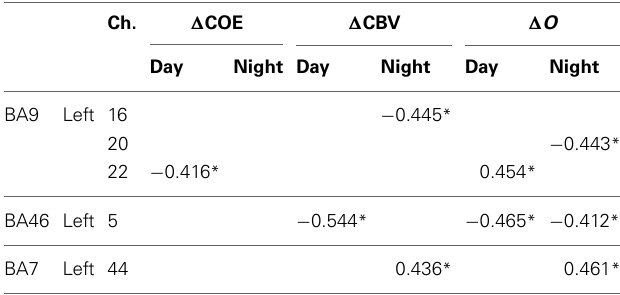
Table 4 | Correlations in the speed increase task between vehicle acceleration and each of the brain activation indices ( p < 0 .